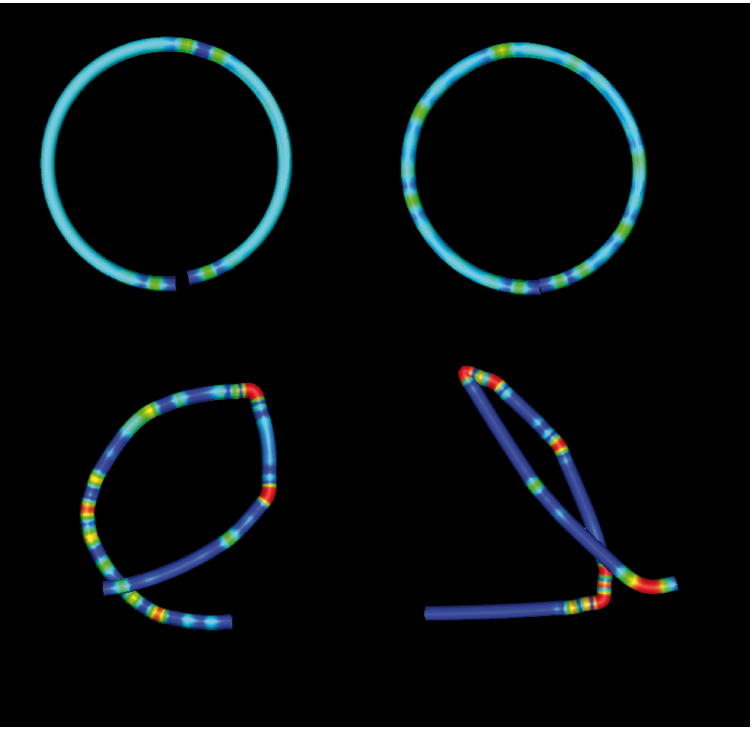
Figure 13 Results of simulated microbending experiments showing individual outcomes. Rod diameter: top left, d = 100 μm; top right, d = 10 μm; bottom left, d = 1 μm; bottom right, d = 0.1